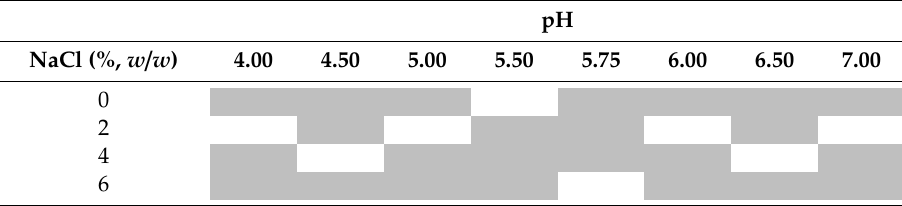
Table 1. Experimental design for the selection of training (gray) and validation (white) conditions for the development of the logistic regression models (experimental time from 1 to 42